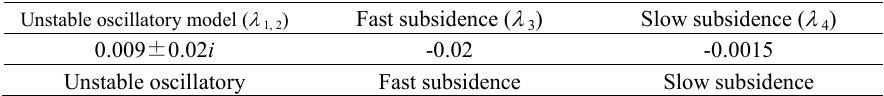
Table 1 Eigenvalues of the system matrix